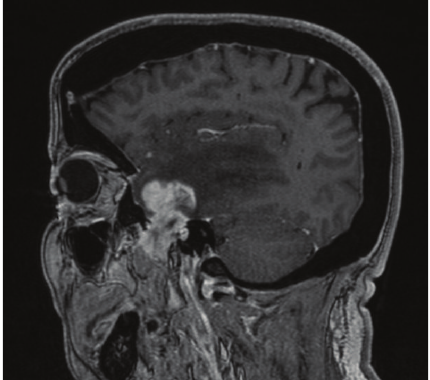
Figure 1: Preoperative enhanced parasagittal T1-WI MRI demon- strates extra-axial heterogeneously dumbbell-shaped enhancing tumor in the left middle fossa extending into infratemporal fossa.